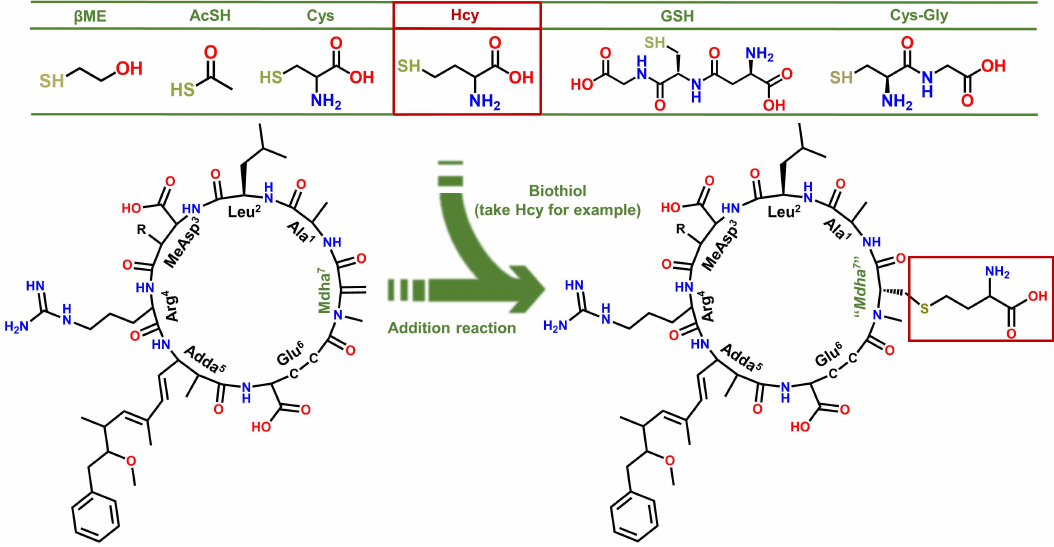
Figure 1. Structures of the MCLR-BTPs resulting from the nucleophilic addition reactions of biothiols to Mdha 7